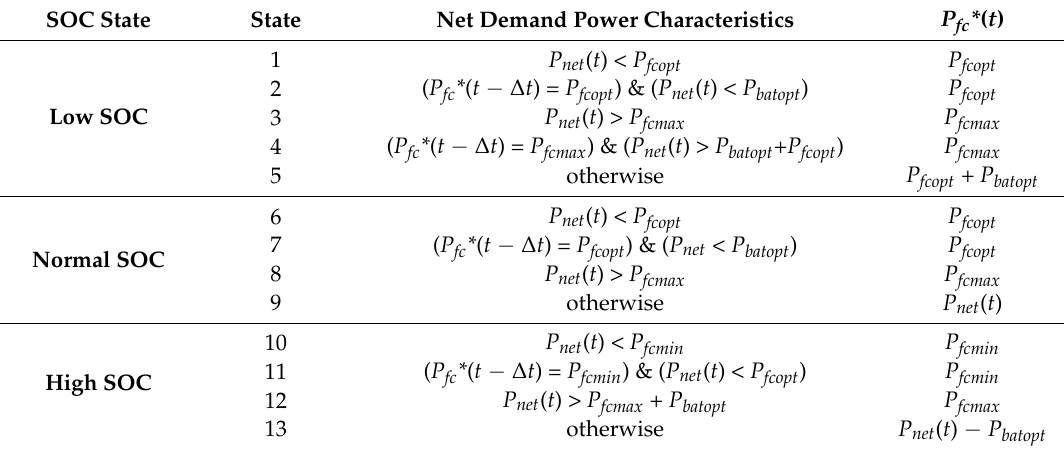
Table 2. Control decisions based on operating states.